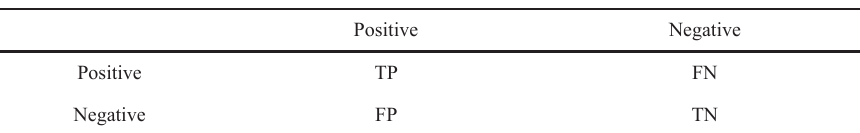
Table 6. Confusion matrix of binary